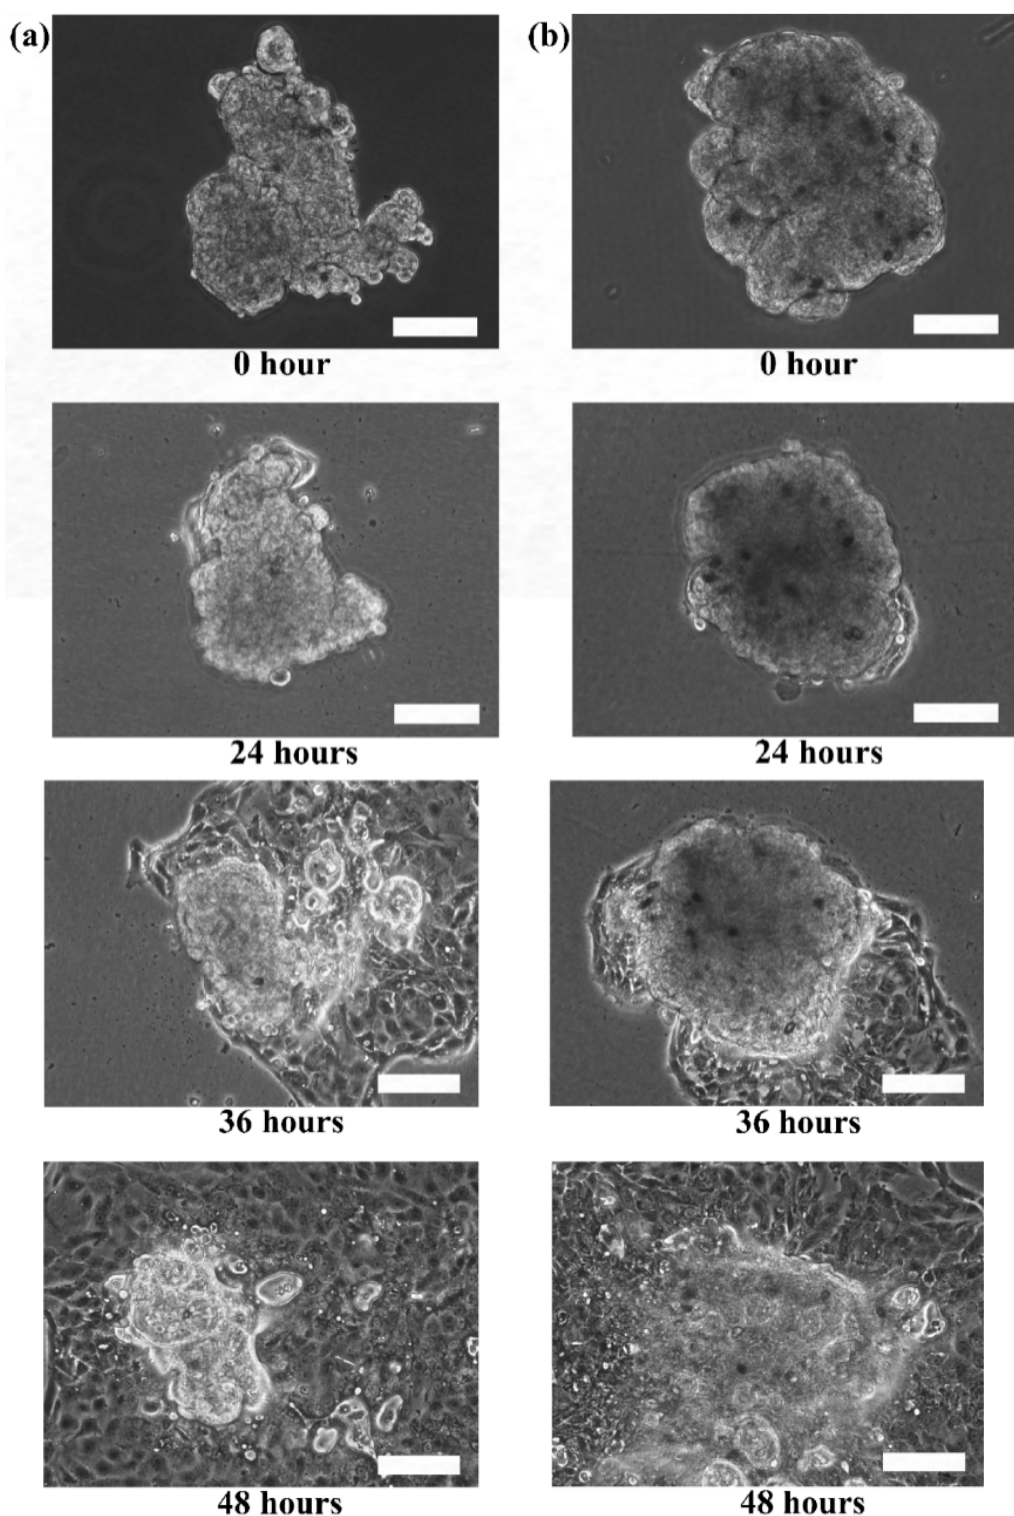
Figure 6. Field emission-scanning electron micrographs of ( a , c ) HaCaT and ( b , d ) ORL-48 microtissue after 15 days of culture at (a,b) 300× and (c,d) 1500× magnifications, respectively (Scale bar: 10 μ m).